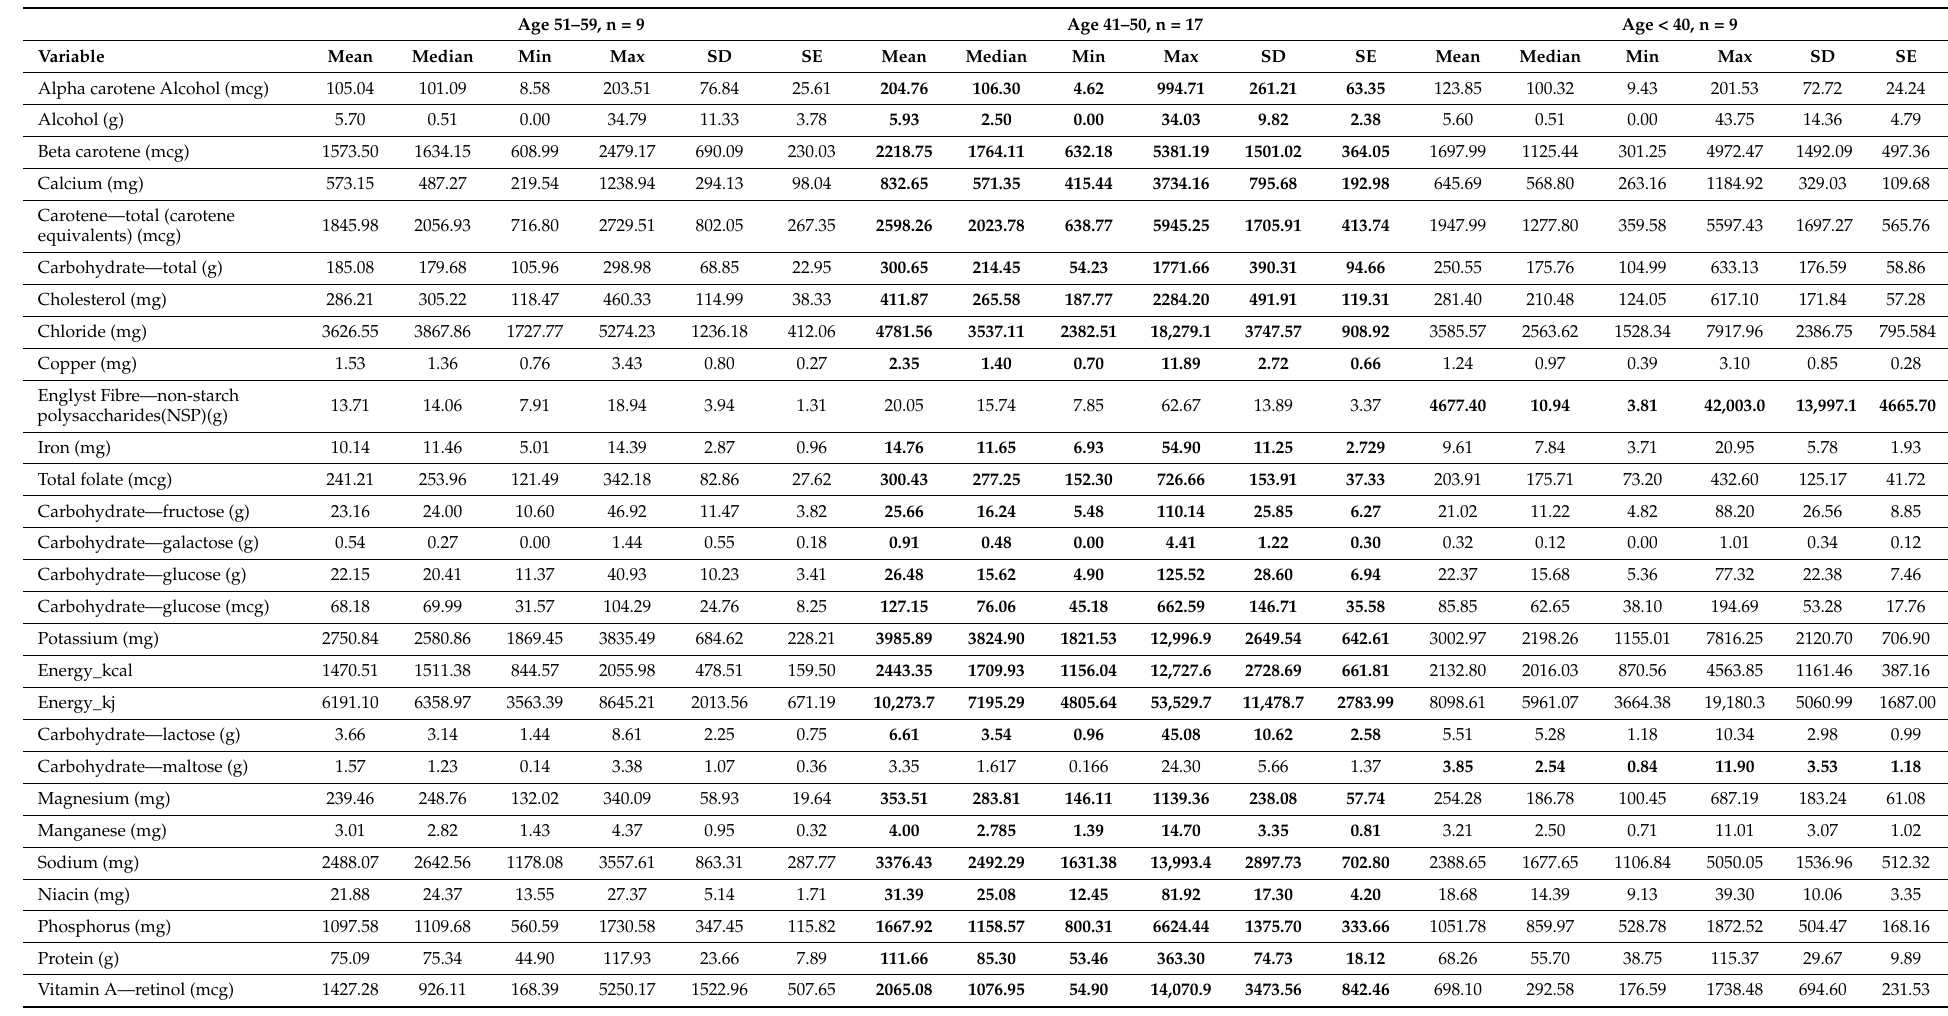
Table 5. The differences in the nutrient intake and food group intake (based on the FFQ questionnaire), together with anthropometric, biochemical and DNA